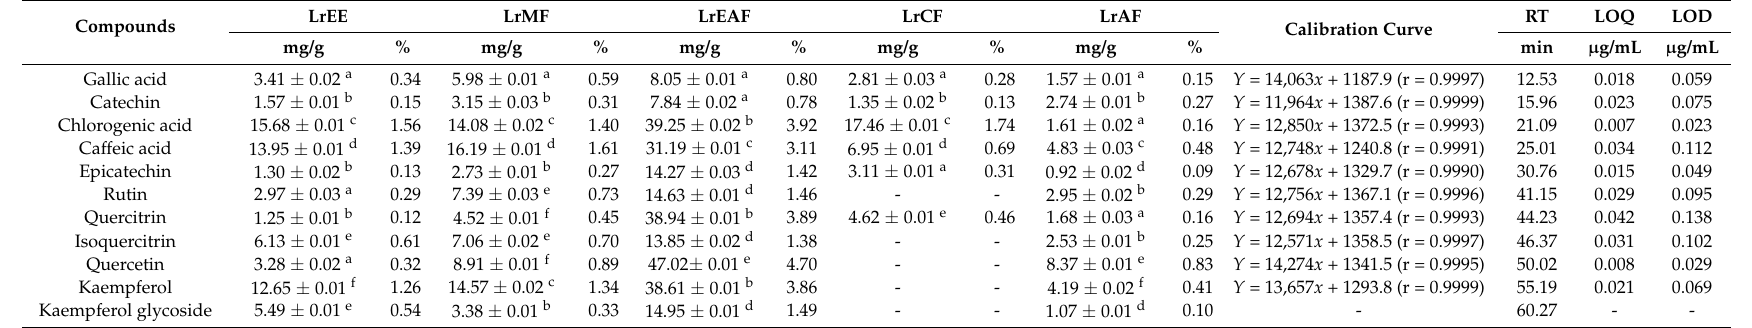
Table 3. Phenolics composition of Licania rigida by HPLC-DAD analysis.